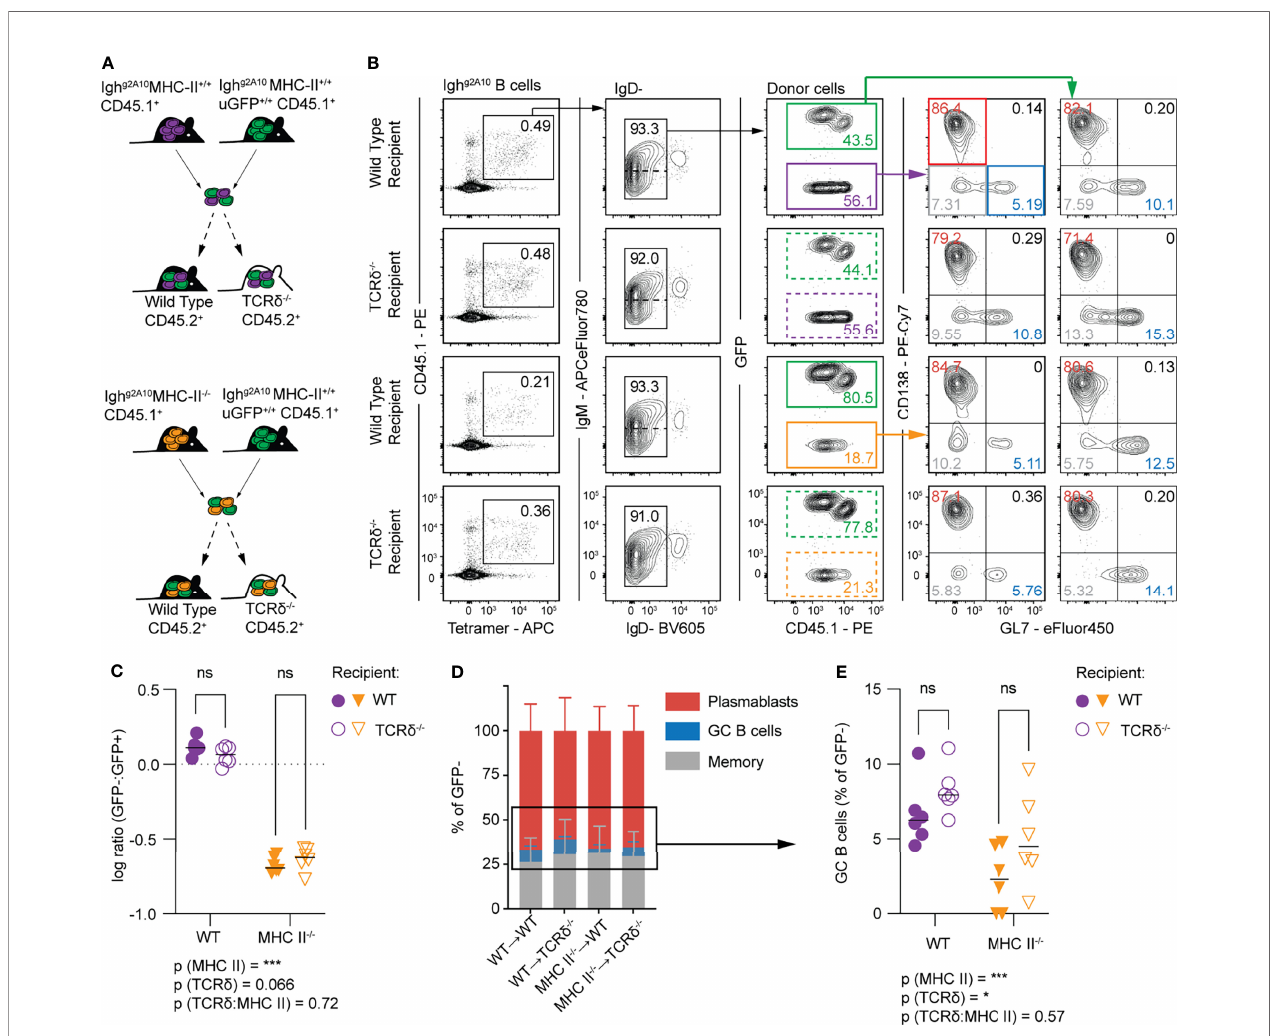
FIGURE 4 | Conventional T cells provide help for GC B cell responses to sporozoites. Wild type (C57BL/6 – WT) or TCR d -/- mice received 1 x 10 4 Igh g2A10 cells which were, depending on group, a combination of wild type and MHC-II -/- cells, prior to immunization with 5x10 4 Pb-Pf CSP SPZ. Four days post-immunization the B cell response was analysed by fl ow cytometry. (A) Schematic depicting experimental strategy for co-transfer of MHC-II +/+ (WT) Igh g2A10 B cells and MHC-II -/- Igh g2A10 B cells. (B) Representative fl ow cytometry gates for identi fi cation of Igh g2A10 B cells 4 days post-immunization, pre-gated upon singlets, lymphocytes, Dump-negative and B cells [CD19 + ± CD138 + ]. Co-transferred B cells can be distinguished by expression of GFP. Phenotype of these B cells subsequently identi fi ed by GL7 (GC) or CD138 (PB) expression. (C) Ratio between the total number of expanded Igh g2A10 B cells from within the co-transferred population, compared for expansion within WT or TCR d -/- host mice. (D) Phenotype of Igh g2A10 B cells as a percentage of total GFP- cells. (E) GC Igh g2A10 B cells from within co-transferred population as a percentage of total GFP- B cells compared for expansion within WT or TCR d -/- host mice. Data pooled from two independent experiments, with 3 mice per group. Analyses were performed using a linear mixed model, with recipient and donor genotypes set as fi xed experiment effects and the different experiments blocked to account for random effects. For (C, E) the overall p-value for the interaction of the fi xed effects is shown under the graph and the pairwise values derived from post tests are indicated on the graph itself. Abbreviations for p values are: ns, not signi fi cant; p < 0.05 = *; p < 0.001 =